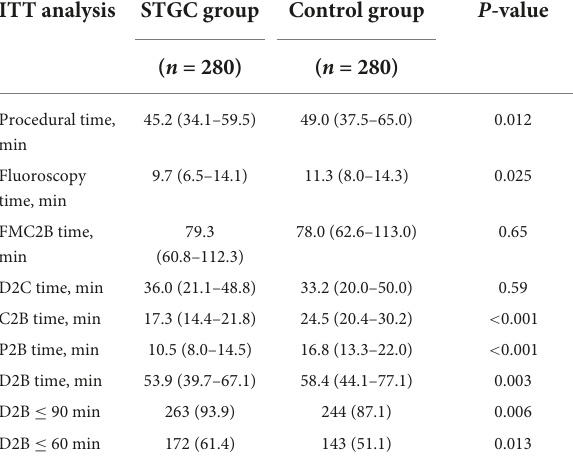
TABLE 3 Treatment times.